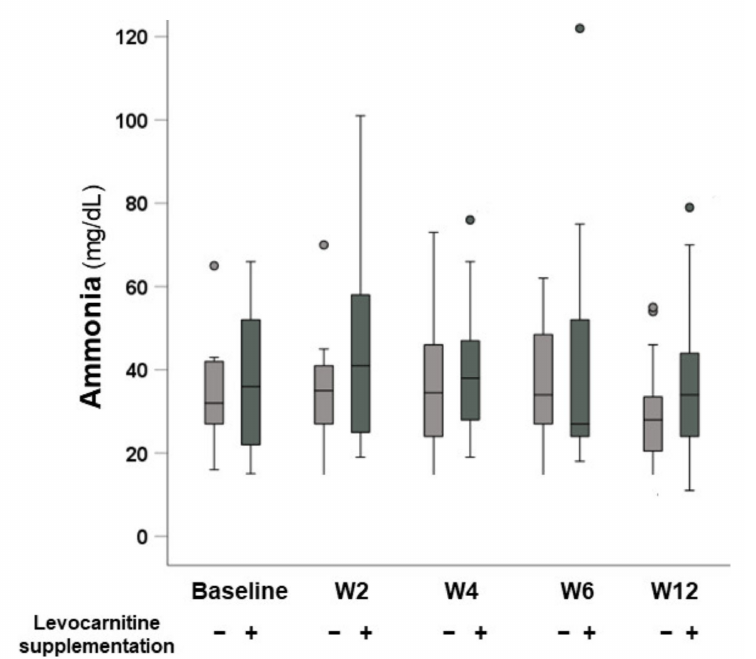
Figure 4. Time courses of serum ammonia levels in patients without and with levocarnitine supple-